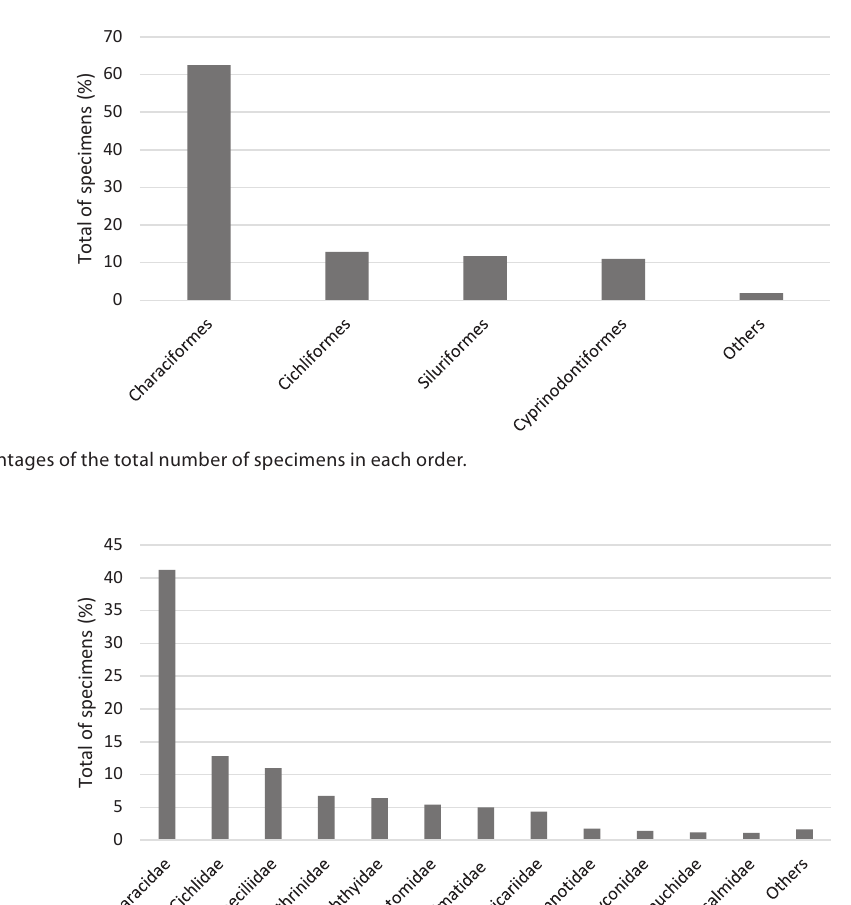
Sampling sites J, K and L of Table 1. Identification. Terminal mouth; premaxila with 2 teeth rows. Silver colored body with a transversal dark‑brow stripe at the posterior region of the caudal peduncle, extend‑ ing through the medial caudal-fin rays. All fins reddish. Original description. Chalceus fasciatus Cuvier 1819: 352, pl. 26.